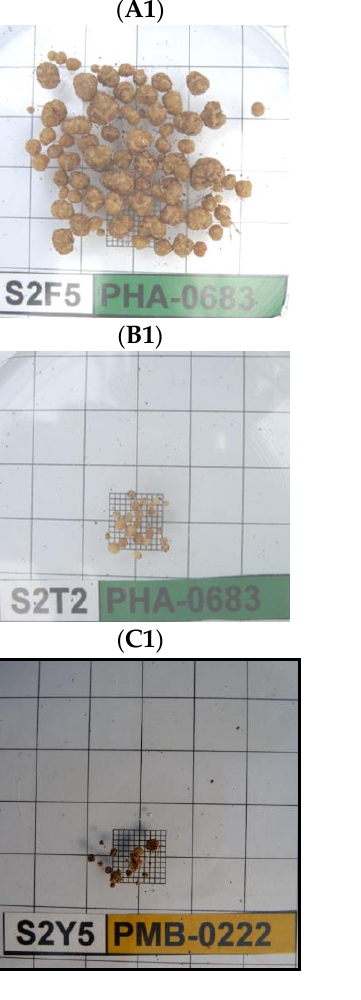
Figure 2. Variation in the size of nodules depending on the bean genotype and the strain. ( A1 , A2 ). BNO nodules in PHA-0683. ( B1 , B2 ). SNO nodules in PHA-0683. ( C1 , C2 ). PMB-0222-EPOB combination showing the difference in size in irrigation and drought.